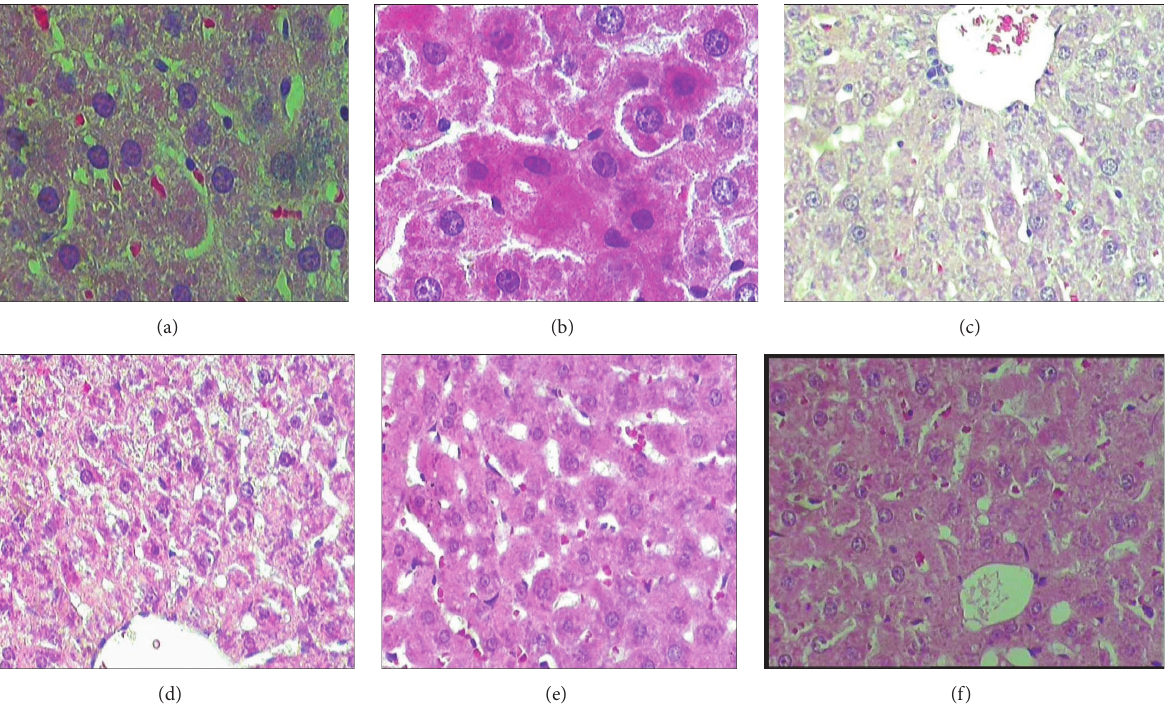
Figure 1: Representative histopathology slides ( × 20) of rat livers from control (untreated) and NVP treated rats and their respective pathology reports. (a) (No NVP): untreated group . “ No pathology appears to be present in the control (untreated) animals ”; (b) (NVP × 2 days): treated with NVP for 2 days. “ Mild granular vacuolar degeneration and cell swelling, scattered cytonecrosis, nuclear pyknosis. Zonal necrosis... minimally present. ”. (c) (NVP × 7 days): treated with NVP for 7 days. “ vacuolar degeneration and cell swelling were moderate, single cell necrosis (cytonecrosis)... minimal centrilobular necrosis. ”. (d) (NVP × 14 days): treated with NVP for 14 days. “ moderate cellular swelling, vacuolar hepatopathy (degeneration) and granular cytoplasm... Hepatic parenchymal cell necrosis (cytonecrosis), and centrilobular zonal necrosis ”. (e) (NVP × 28 days): treated with NVP for 28 days. “ Granular vacuolar degeneration and cell swelling were minimal, as well as cytonecrosis. ”. (f) (NVP × 42 days): treated with NVP for 42 days. “ Centrilobular hepatocytes with minimal (1+) degeneration visible